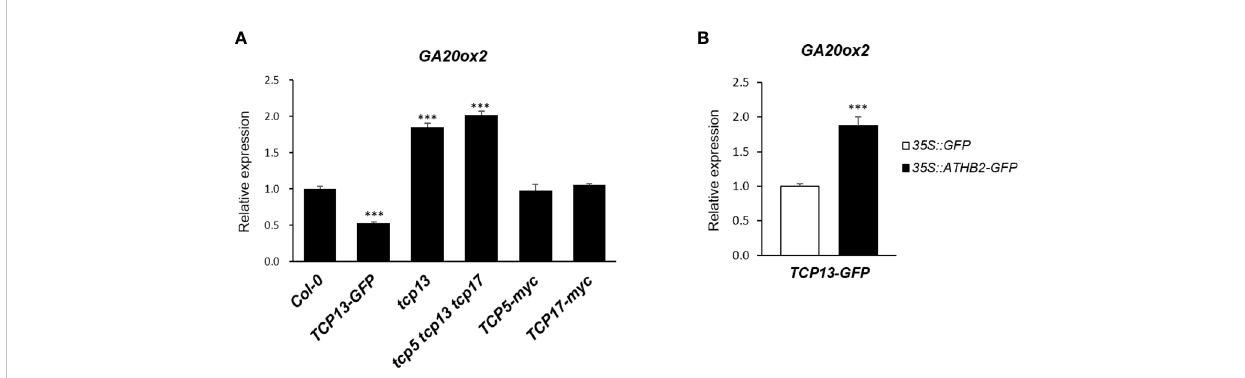
FIGURE 4 Regulation of GA20ox2 expression in TCP13 -expressing transgenic plants, protoplasts, and mutants. (A) Expression of GA20ox2 in Arabidopsis seedlings with 35S promoter-driven TCP13-GFP fusion construct ( TCP13-GFP ), tcp13 mutant, triple KO mutant for TCP13 and its paralogs, TCP5 and TCP17 ( tcp5 tcp13 tcp17 ), seedlings with 35S promoter-driven TCP5-myc fusion construct ( TCP5-myc ), and those with 35S promoter-driven TCP17-myc fusion construct ( TCP17-myc ) examined by real-time quantitative PCR. (B) Expression of GA20ox2 in Arabidopsis protoplasts of TCP13-GFP transgenic plants that were subsequently transfected with 35S promoter-driven ATHB2-GFP fusion construct ( 35S pro::ATHB2-GFP ) examined by real-time quantitative PCR. More than 3 independent transgenic plants expressing TCP5 , TCP13 or TCP17 , respectively. Results are representative of more than three independent experiments. Data shown are mean ± SD (n > 3). All data were statistically evaluated using one- way ANOVA: ***P <